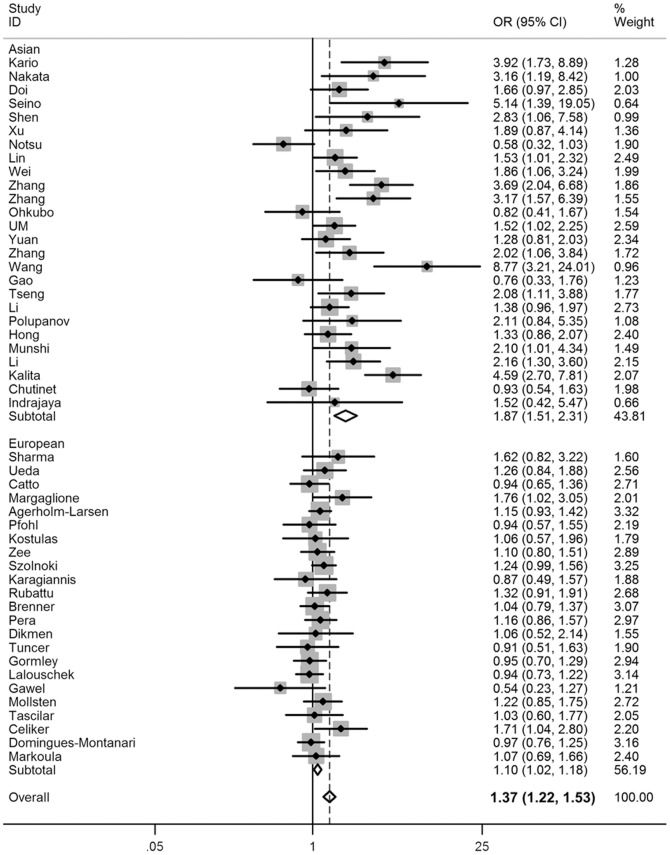
Forest plot of stroke risk associated with the ACE I/D polymorphism (DD vs ID/II).